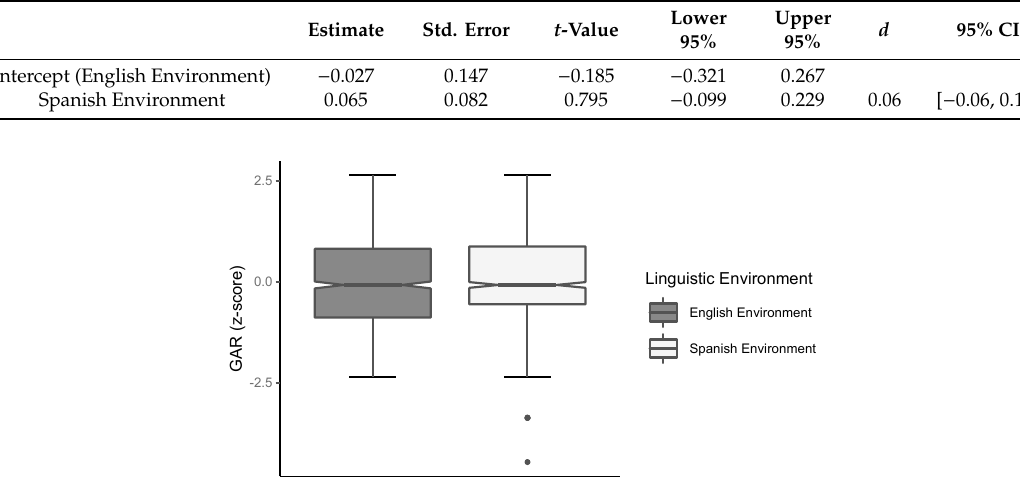
Figure 5. Global accent rating (z-scored) by linguistic environment.